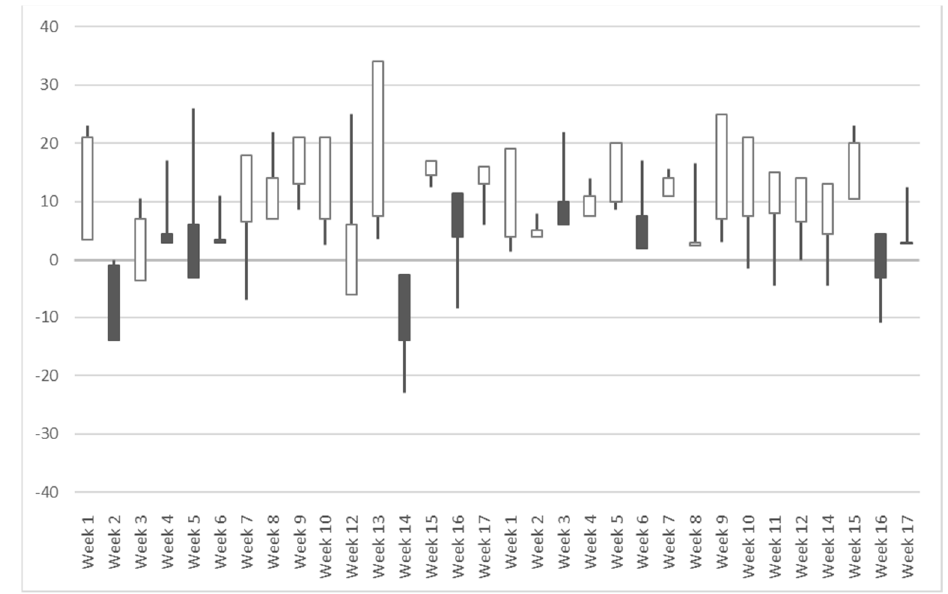
Figure 2. Candlestick chart of New England in 2015/2016 and 2016/2017.